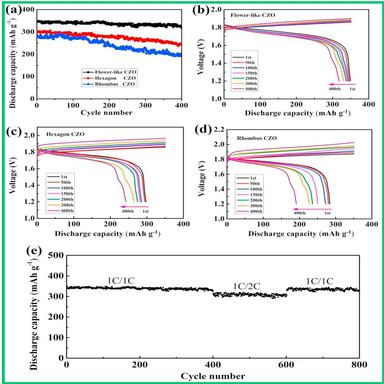
(a) Cyclic performance of the as-prepared calcium zincate electrodes by cycling at charge/discharge rates of 1C/1C for 400 cycles; The corresponding charge-discharge curves of the (b) Flower-like calcium zincate, (c) Hexagon calcium zincate and (d) Rhombus calcium zincate electrodes at various cycles; (e) Cyclic performance of the as-prepared calcium zincate electrodes by cycling at charge/discharge rates of 1C/1C for 600 cycles and 1C/2C for 200 cycles.